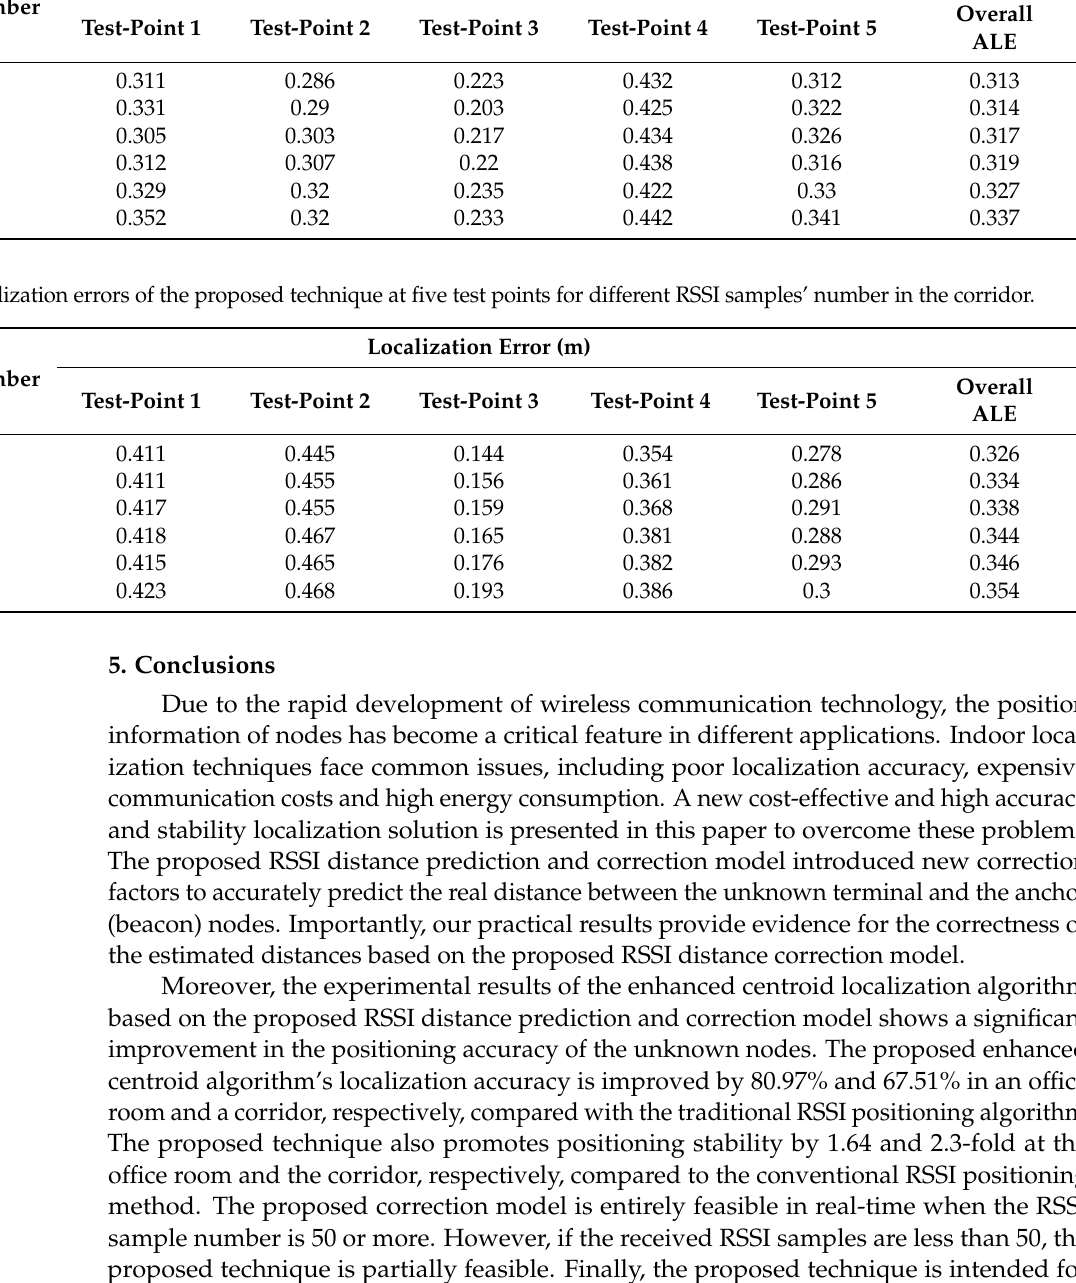
Table 7. The localization errors of the proposed technique at five test points for different RSSI samples’ number in the office room.